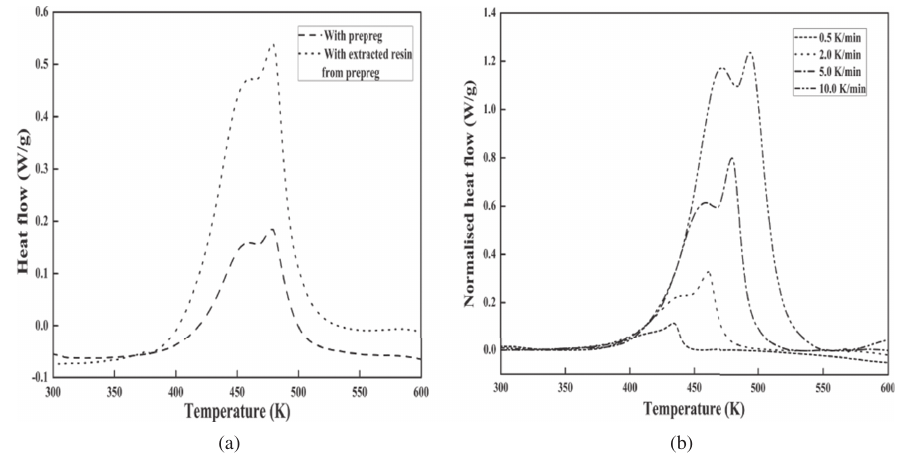
Figure 3: Dynalmic DSC scan: (a) Heat flow from prepreg and extracted resin at same heating rate (b) Normalized heat flow from extracted resin at different heating rate.